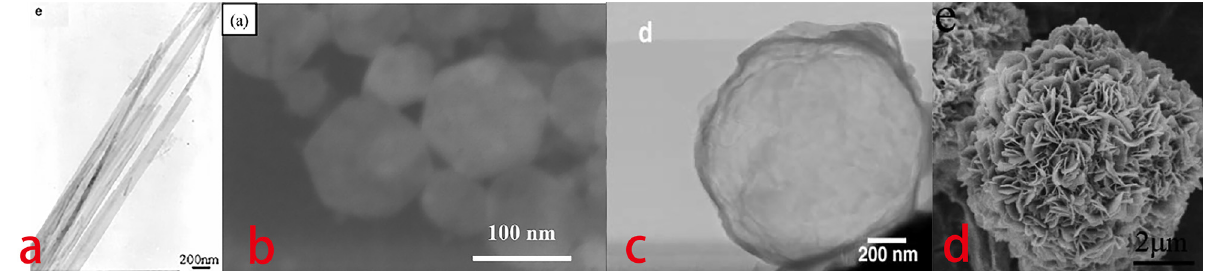
Figure 2: The SEM micrograph of di ff erent LDH micro - structure: ( a ) nanotube [ 41 ] ; ( b ) nanosheets [ 42 ] ; ( c ) nanoshells [ 43 ] ; and ( d ) hierarchical sphere [ 44 ]